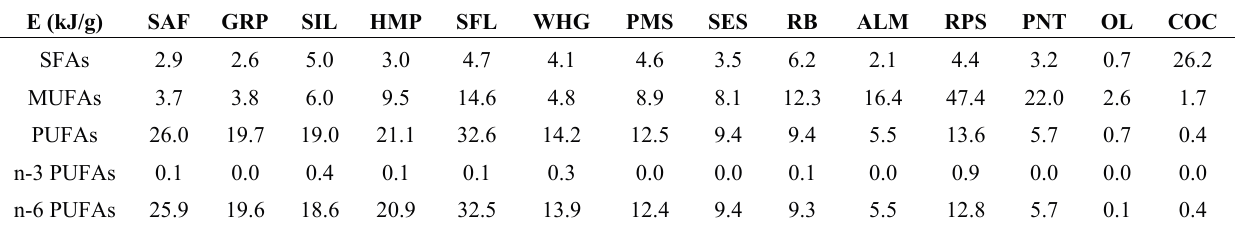
Table 2. Energy values (E, kJ/g) of different fatty acid groups derived from 1 g of vegetable oils 1 .